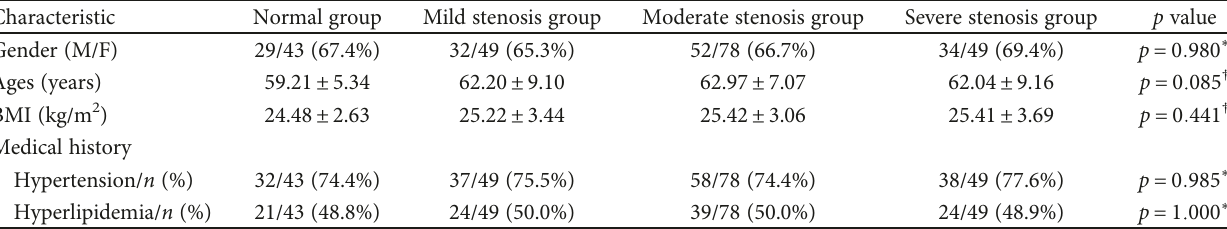
Table 1: Characteristics of participants.